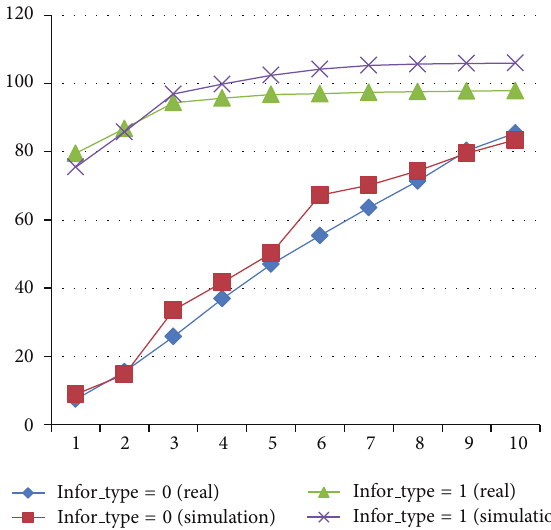
Figure 3: Comparison of retweeting tendency of different types of knowledge.